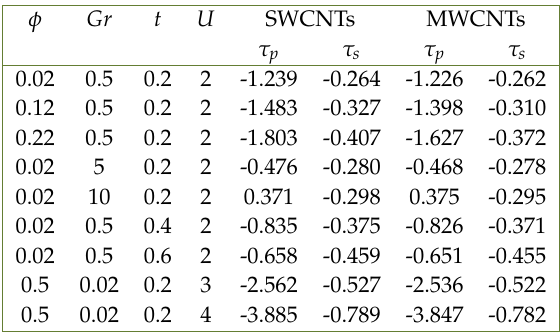
Table 2. Variant of skin friction for embedded parameters at Pr =6.2.